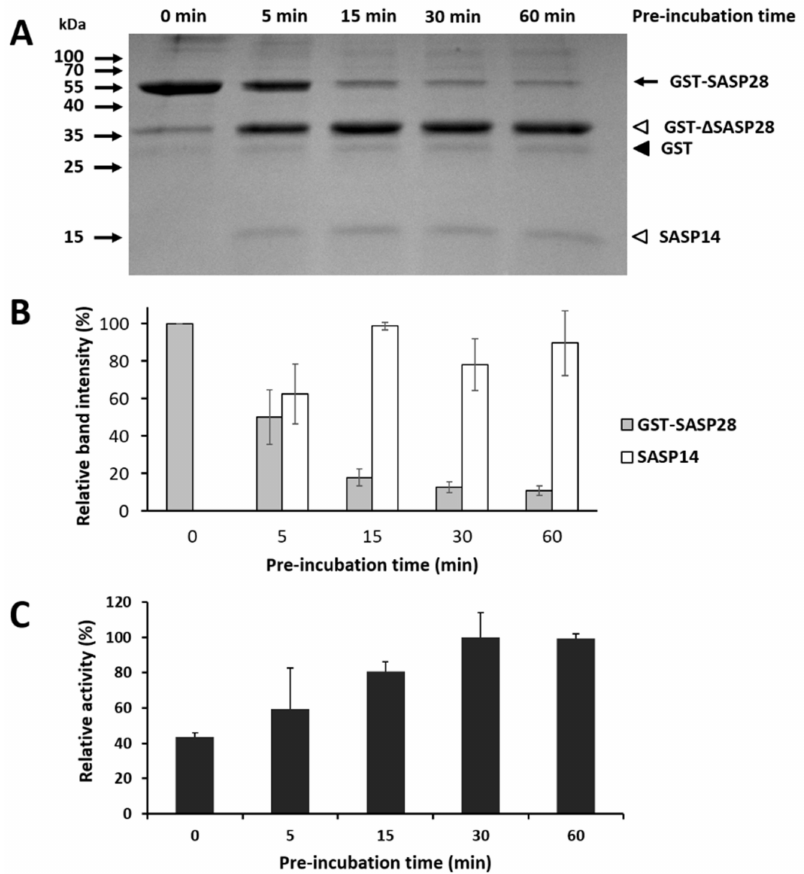
Figure 11. ASPRV1 is activated by autoproteolysis of the precursor. ( A ) A representative SDS-PAGE gel image shows self-processing of the full-length GST-SASP28 precursor and the release of SASP14. The purified GST-SASP28 was pre-incubated in reaction bu ff er for 0, 5, 15, 30, and 60 min. Black arrow indicates full-length GST-SASP28 precursor, white arrowheads indicate GST- ∆ SASP28 and SASP14 as autoproteolytic cleavage fragments, while GST is shown by black arrowhead. ( B ) The relative band intensities were determined via densitometry of the gels. For GST-SASP28 and SASP14, the most intense band was considered to have 100% intensity in the case of each gel. Error bars represent SD ( n = 3). ( C ) The e ff ect of self-processing on enzyme activity was investigated by measuring the hydrolysis of VSQLY ↓ PIVQ oligopeptide substrate, using an HPLC-based method. Relative activities are plotted as a function of time of pre-incubation for all samples. Error bars represent SD ( n =